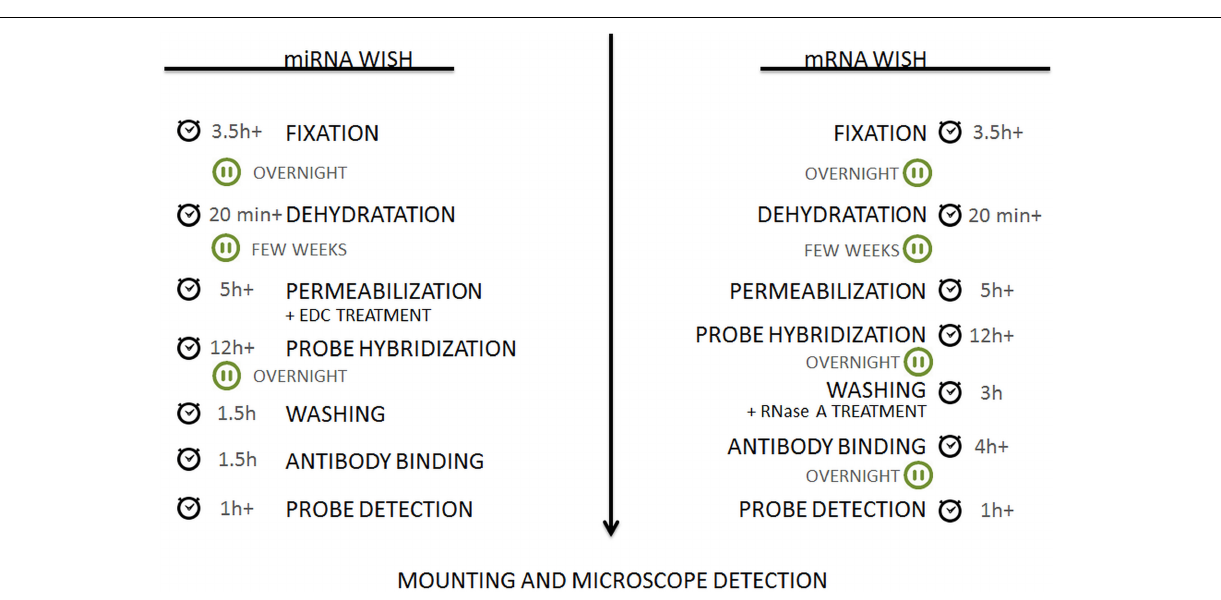
Frontiers in Plant Science |